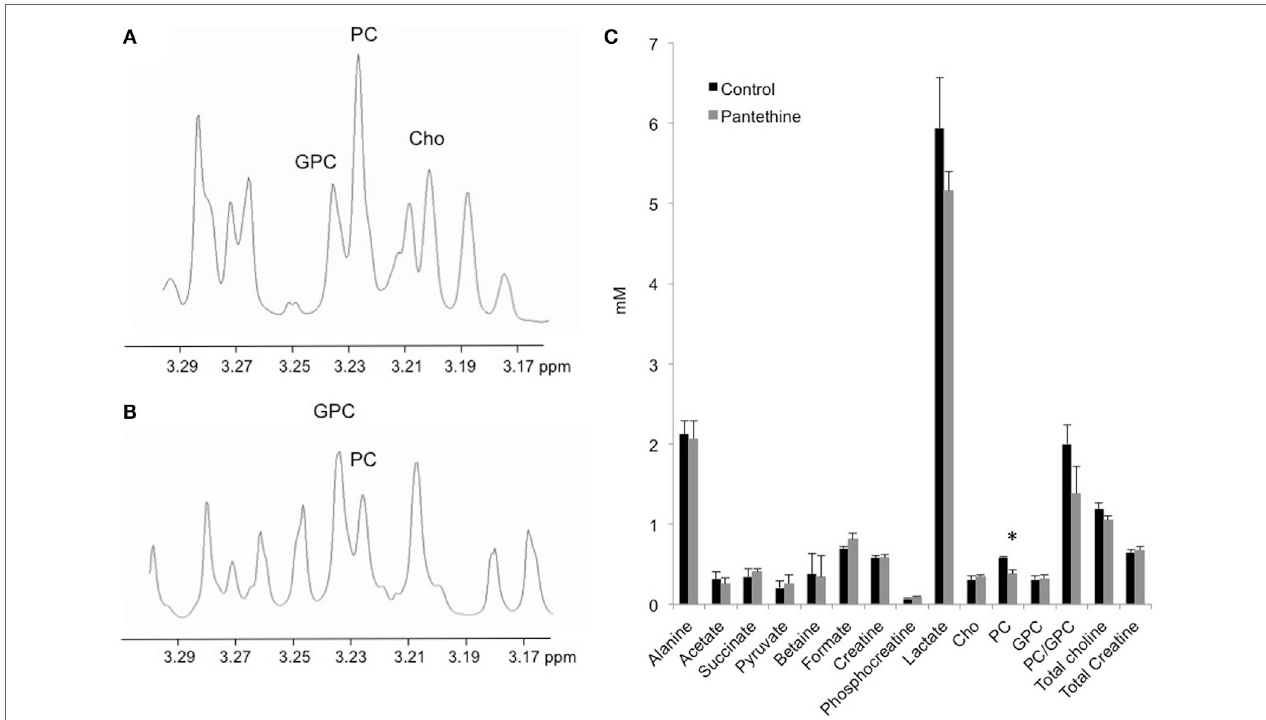
FigUre 5 | representative water phase 1 h Mr spectra centered around the 3.2 ppm region from a control (a) and a treated (b) mice . (c) Metabolite quantification from control and treated tumor extracts ( n = 5; mean ± SD are represented; * P < 0.05).